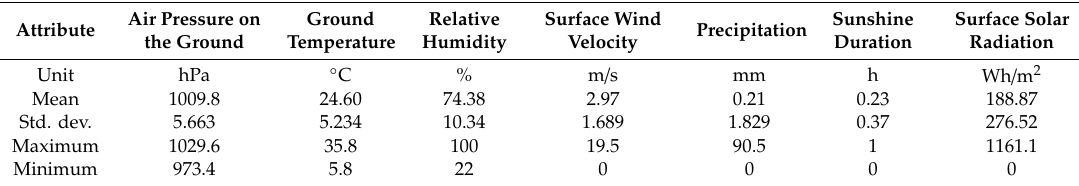
Table 2. Weather attributes and statistics at the Tainan station.